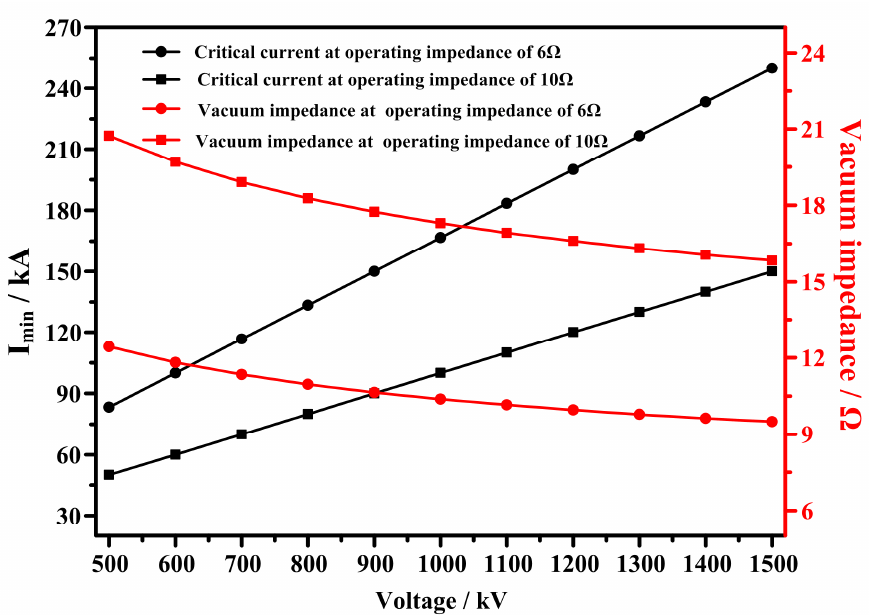
Figure 6. Variation in the critical current with the working voltage under different running imped- ances.